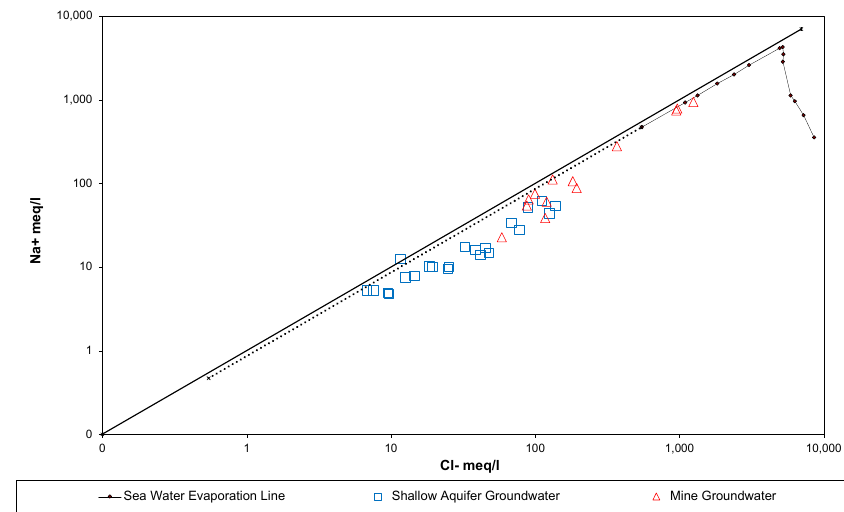
Figure 4. Plot of sodium versus chloride of shallow aquifer and mine groundwater.